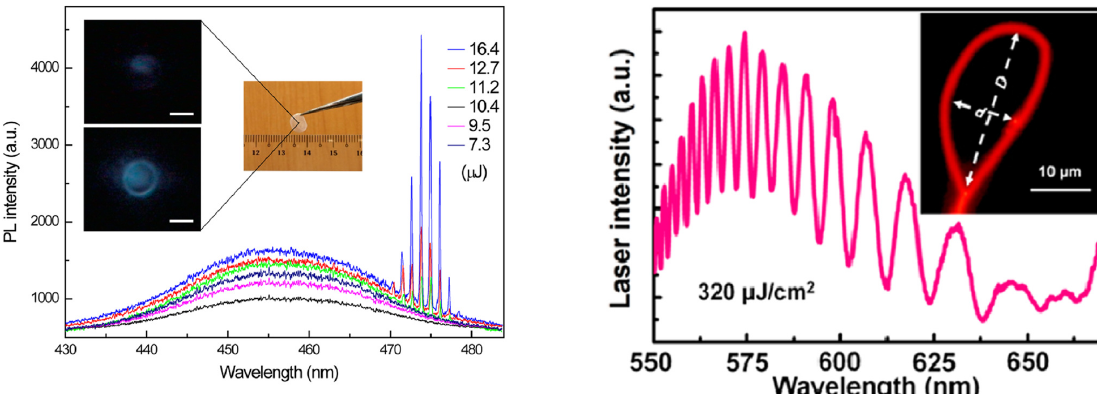
Figure 9. ( left ) Pump power dependent micro PL spectra from a single microbubble with diameter of about 34 µ m. The inset shows a photograph of the free-standing CQD/PMMA nanocomposite film and the PL images of the microbubble below (upper one) and above (bottom one) threshold (scale bar 20 µ m). Reproduced with permission from [74]. American Chemical Society, 2017. ( right ) multimode laser emission spectrum of a ring resonator at an optical pump of 320 µ Jcm − 2 . Inset: dark-field PL image